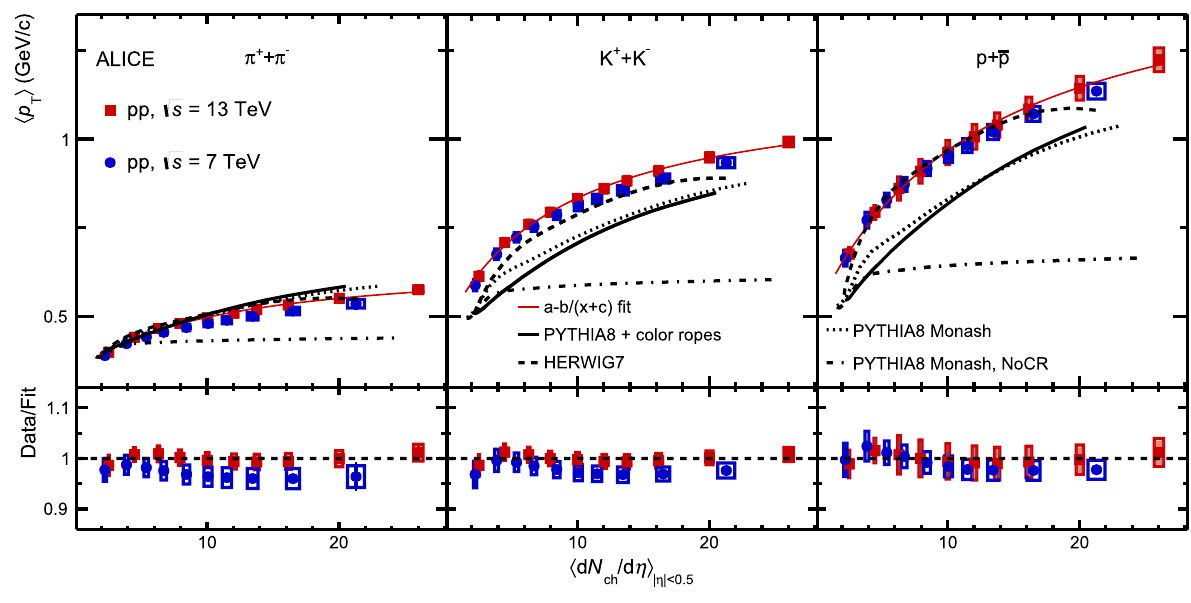
Fig. 7 Upper panels: average transverse momenta of π , K, and p as a function of charged-particle multiplicity density measured in pp √ s = 7 and 13 TeV. The red solid line represents collisions at a − b ( c − (cid:4) d N ch / d η (cid:5) ) − 1 fit to the 13 TeV data to guide the eye. Open